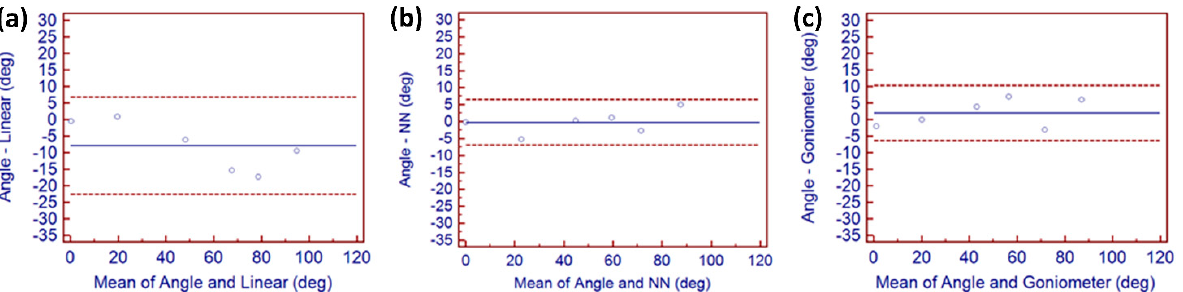
Figure 5. Bland–Altman limit of agreement charts for little MCP showing ( a ) levels of agreement between precise angles and those linearly generated by the data glove linear method, ( b ) levels of agreement of precise angles and those generated using NN technique, and ( c ) levels of agreement between precise angles and those recorded from a goniometer.